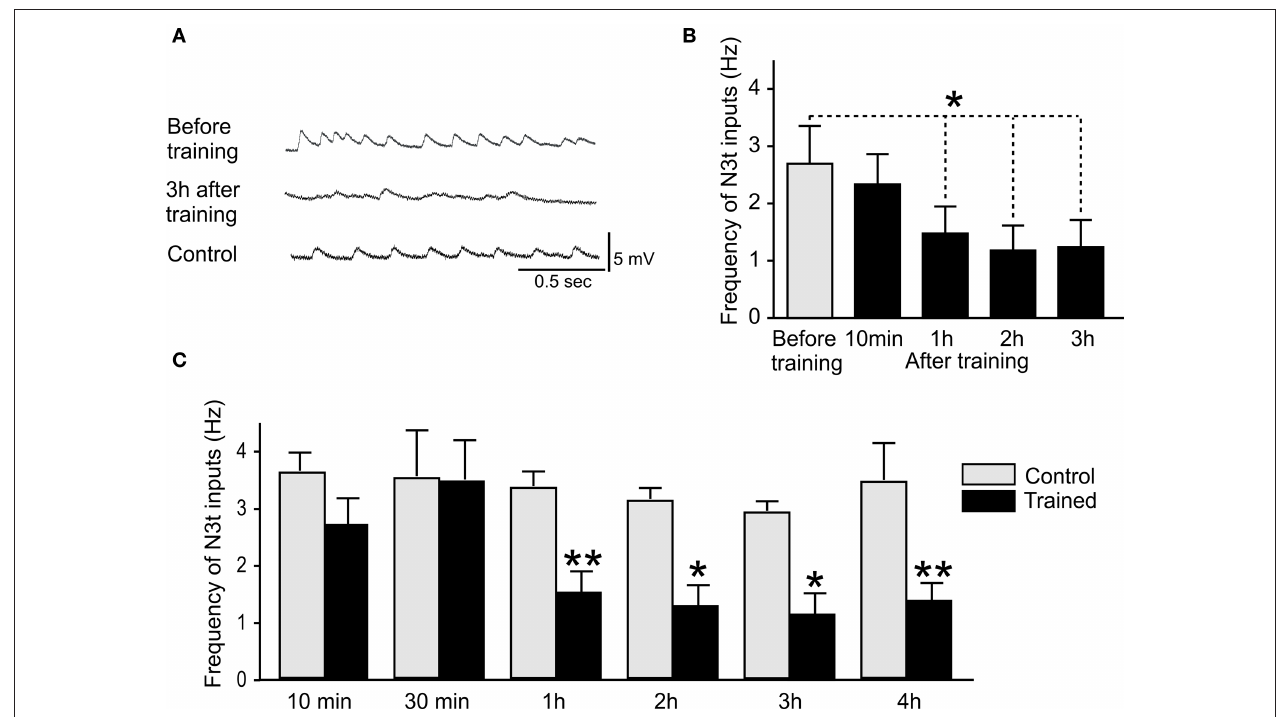
Figure 3 | reduction in N3t frequency following single-trial conditioning. (A) Intracellular recordings showing examples of N3t synaptic inputs on B3 motoneurons. The top trace shows the N3t-driven inputs before pairing, the middle trace, a B3 motoneuron 3 h after pairing. The frequency of the N3t inputs is lower than before pairing. The bottom trace is an intracellular recording of a B3 motoneuron from a control preparation at the 3-h time point. The frequency of the N3t inputs in control preparations is higher than in the experimental preparation at the same time point, and similar to the frequency